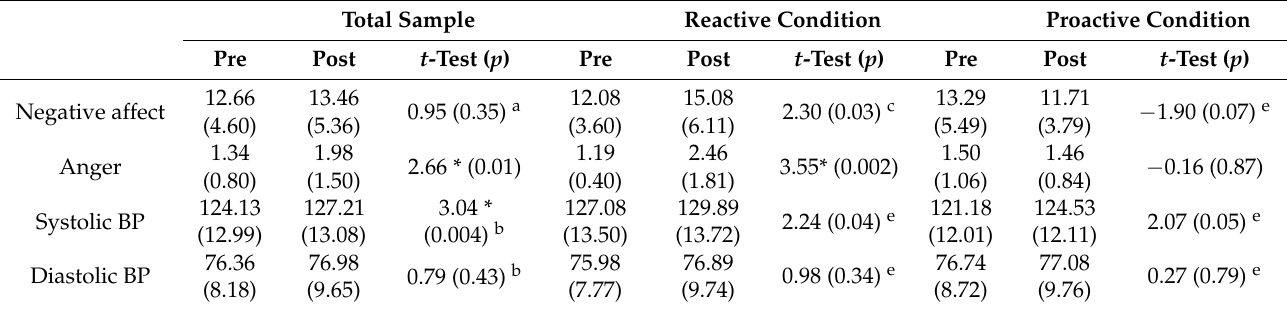
Table 5. Study 2: Changes, mean, and SD in pre–post affect and blood